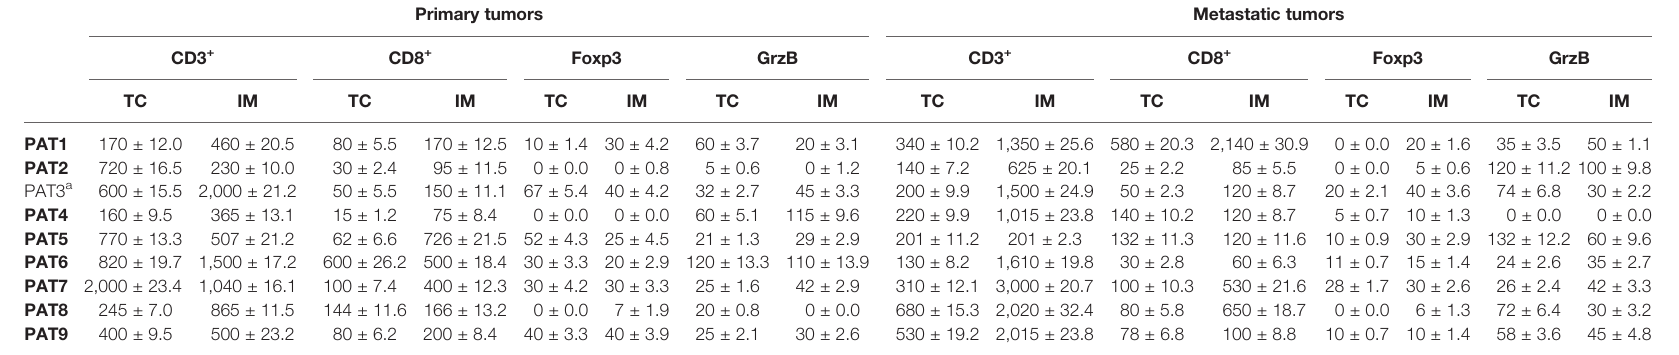
TABLE 4 | Distribution of T-cell subset densities (cells/mm 2 ) in primary and oligometastatic